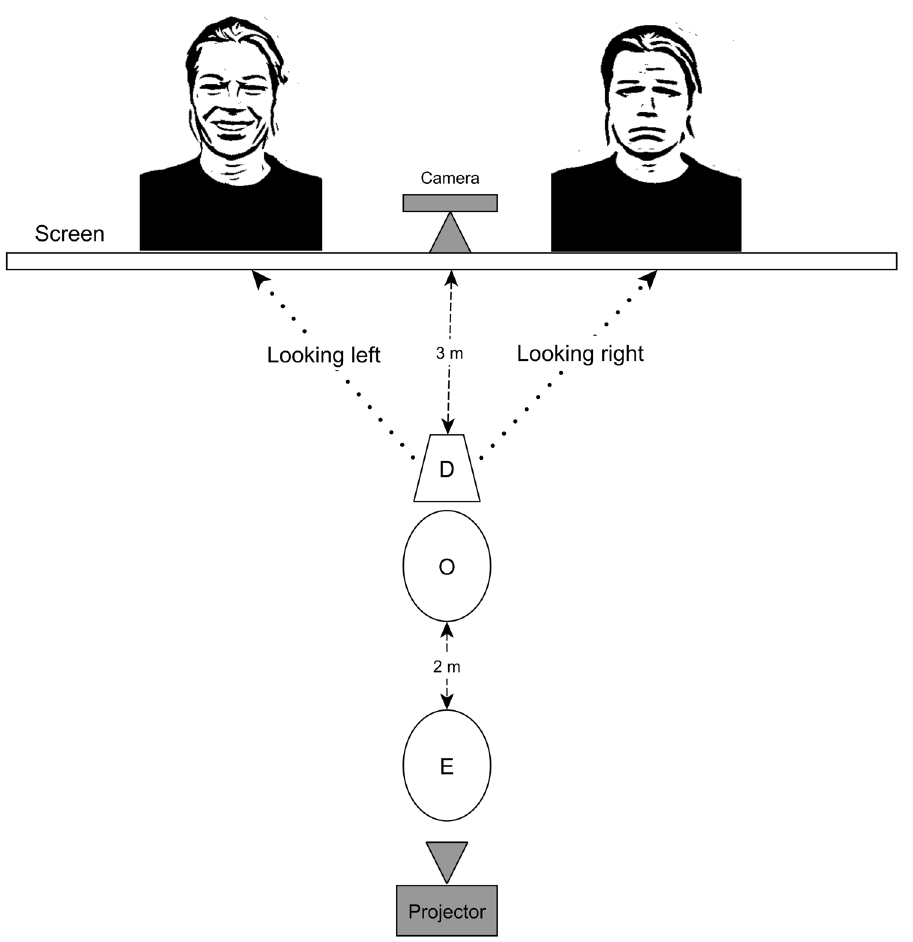
Figure 2. Experimental setup for the emotion recognition task (happy face left, sad face right). E = Experimenter, O = Owner, D =